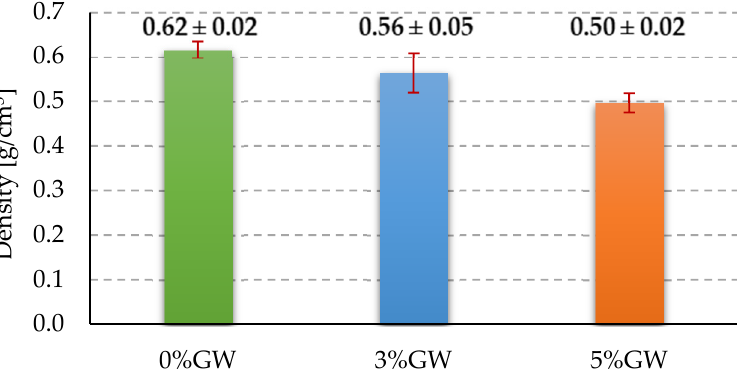
Figure 6. Density results of tested materials.